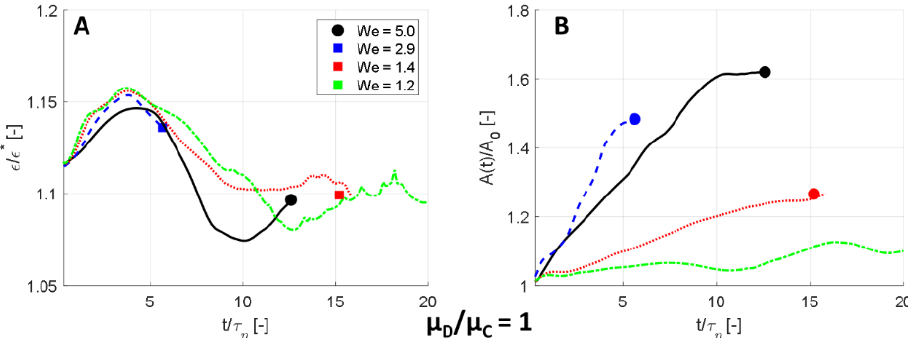
Figure 10. Suppression of turbulence for the low viscosity drop ( µ D / µ C = 1.0). ( A ) Dissipation rate of TKE, ε , normalized to the one-phase flow time-averaged value, ε * , as a function of time, t . ( B ) Total interfacial area, A , normalized with its initial value, A 0 .